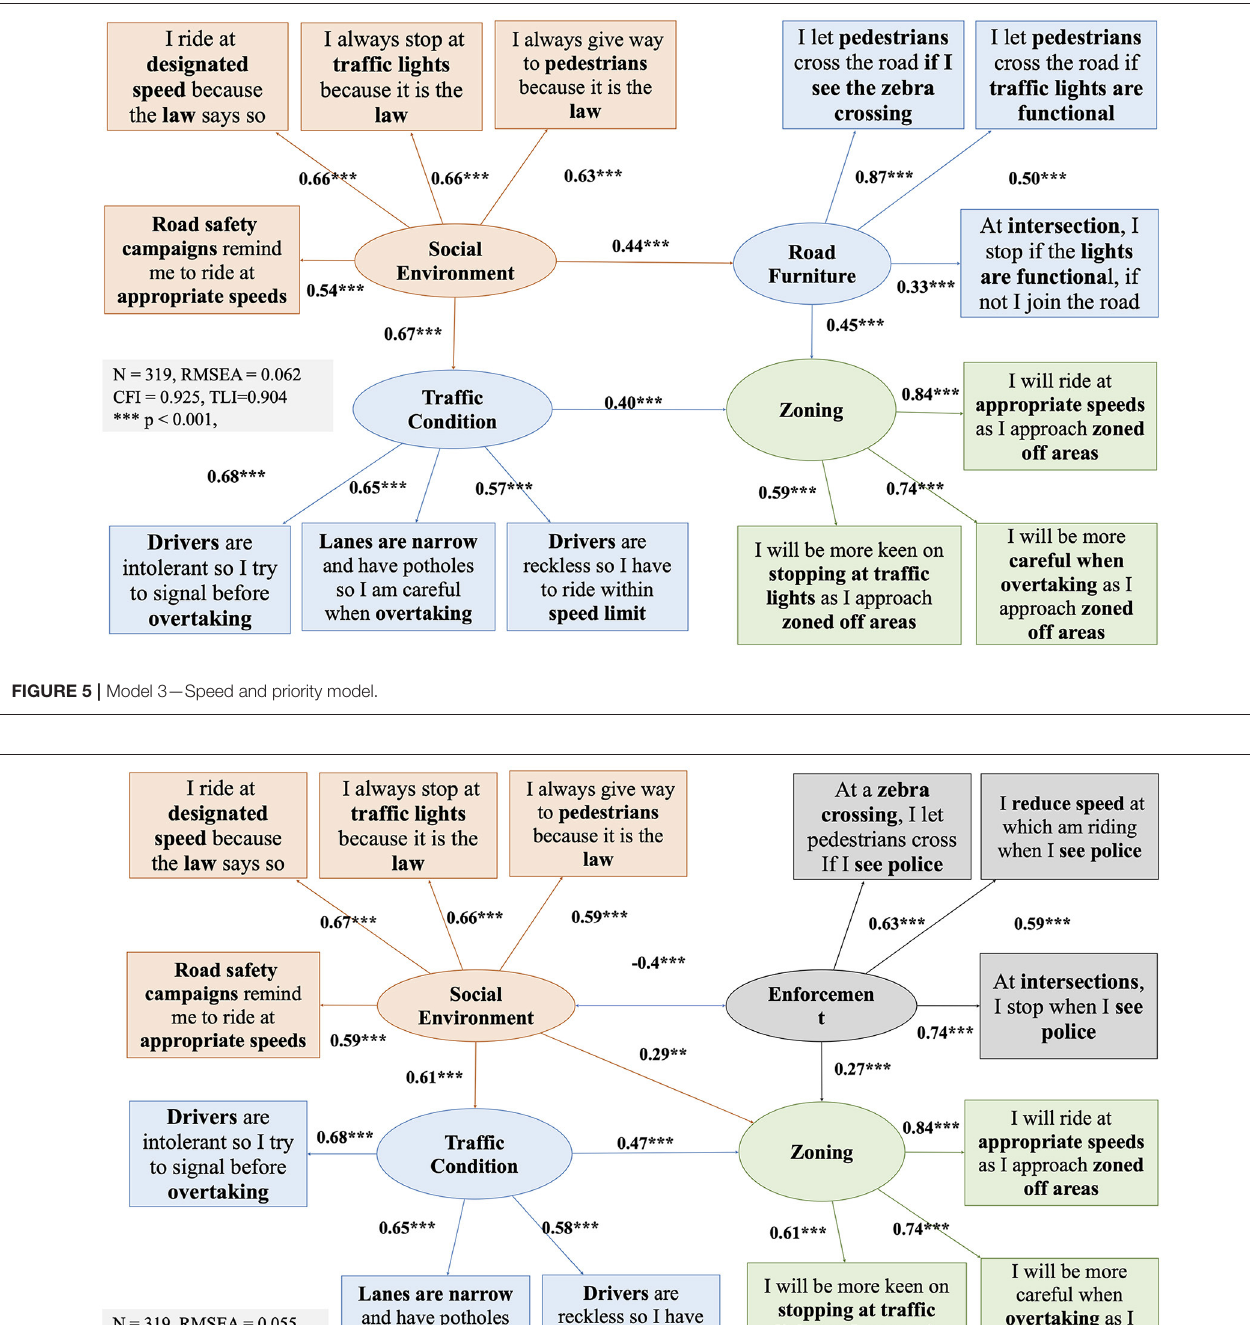
GFI = 0.946, AGFI = 0.919). Model 4 ( Figure 6 ) is similar